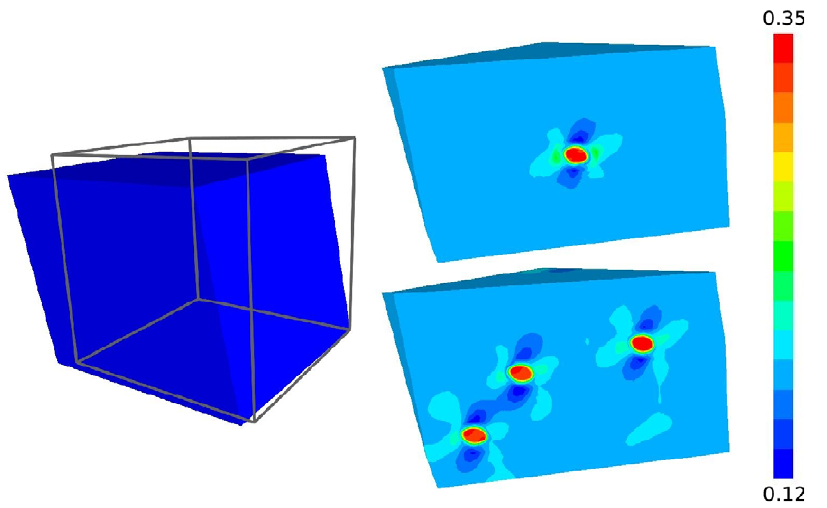
Figure 7. An example of the internal effective strain distributions observed in a single (top right) and 11 cell (bottom right) micro- scale solution for the same deformation gradient passed from the macro-scale (left). A macro-scale finite element experienced a combined loading deformation gradient which resulted in a shape change from the gray cube to the blue hexahedron shown on the left. The single and 11 cell models were deformed in the same way with the resulting effective strain distributions in a cross-section of the model shown on the right. While the cells experienced qualitatively similar strains in both cases, the strain in the ECM around the cells in the 11 cell model differed from the single cell in regions of close cellular proximity. See Table 4 for cell-specific quantitative results.